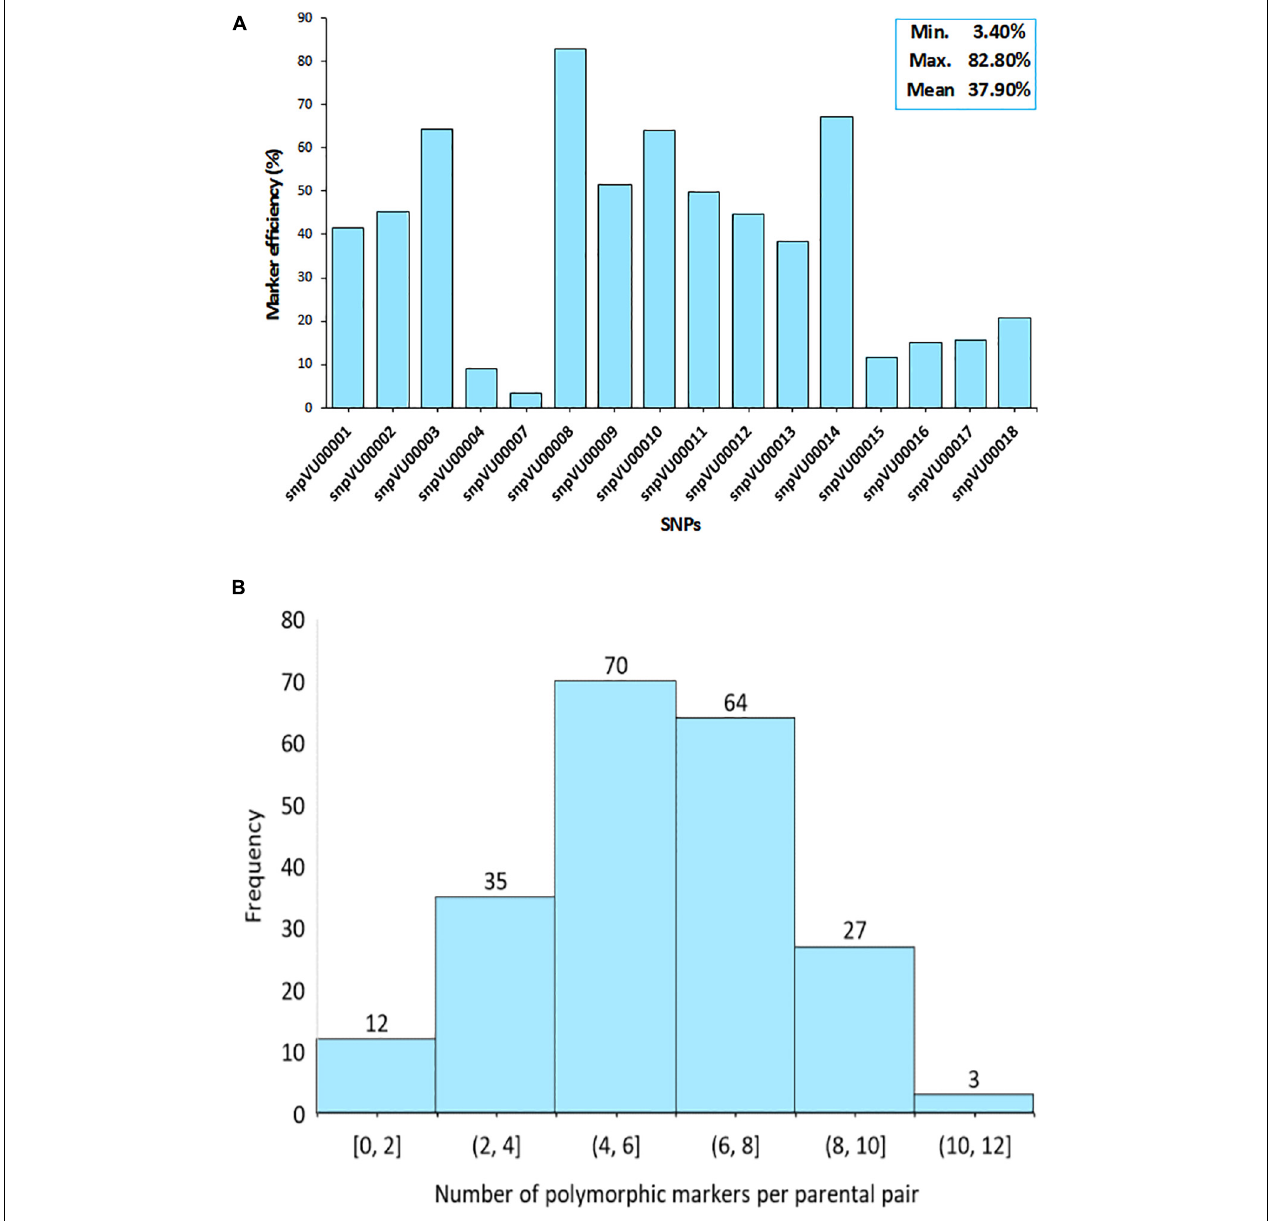
FIGURE 3 | Informativeness of markers in differentiating parental pairs. (A) Bar chart shows the efficiency of each single nucleotide polymorphism (SNP) marker in distinguishing between pairs of parents. Insert on top right-hand corner is the summary statistics for marker efficiency indicating the Minimum, Maximum, and the Mean values. (B) Histogram depicts the distribution of polymorphism among pairs of parents as a measure of marker efficiency. Percentage of polymorphic markers in a cross is shown on the x -axis while the number of crosses is on the y